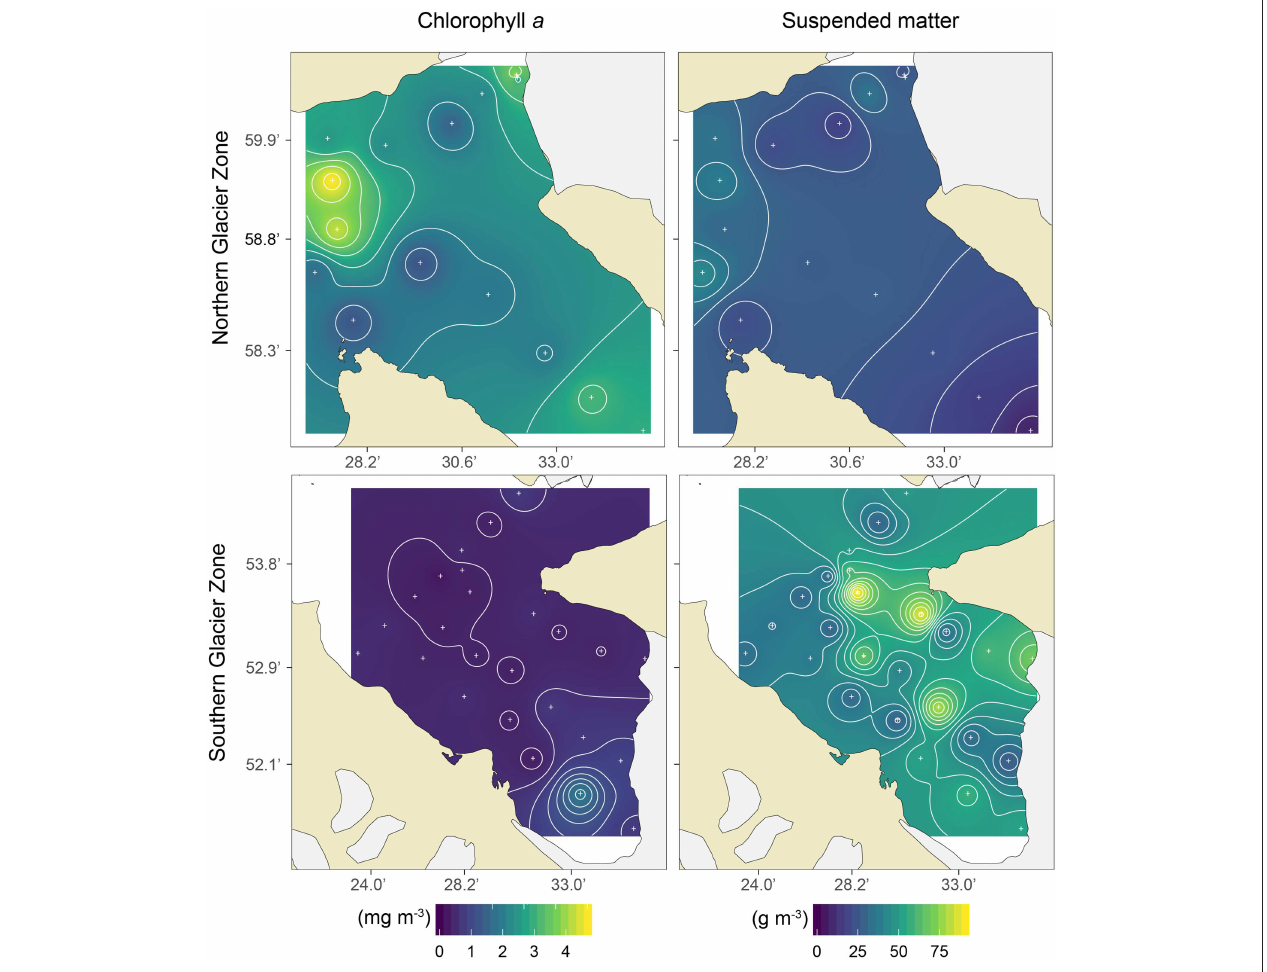
FIGURE 4 | Surface ( ≤ 10m) Chlorophyll a (mg m − 3 ; left panels) and suspended matter (g m − 3 ; right panels) concentrations in the Northern Glacier Zone (upper panels) and Southern Glacier Zone (lower panels) in Kongsfjorden.